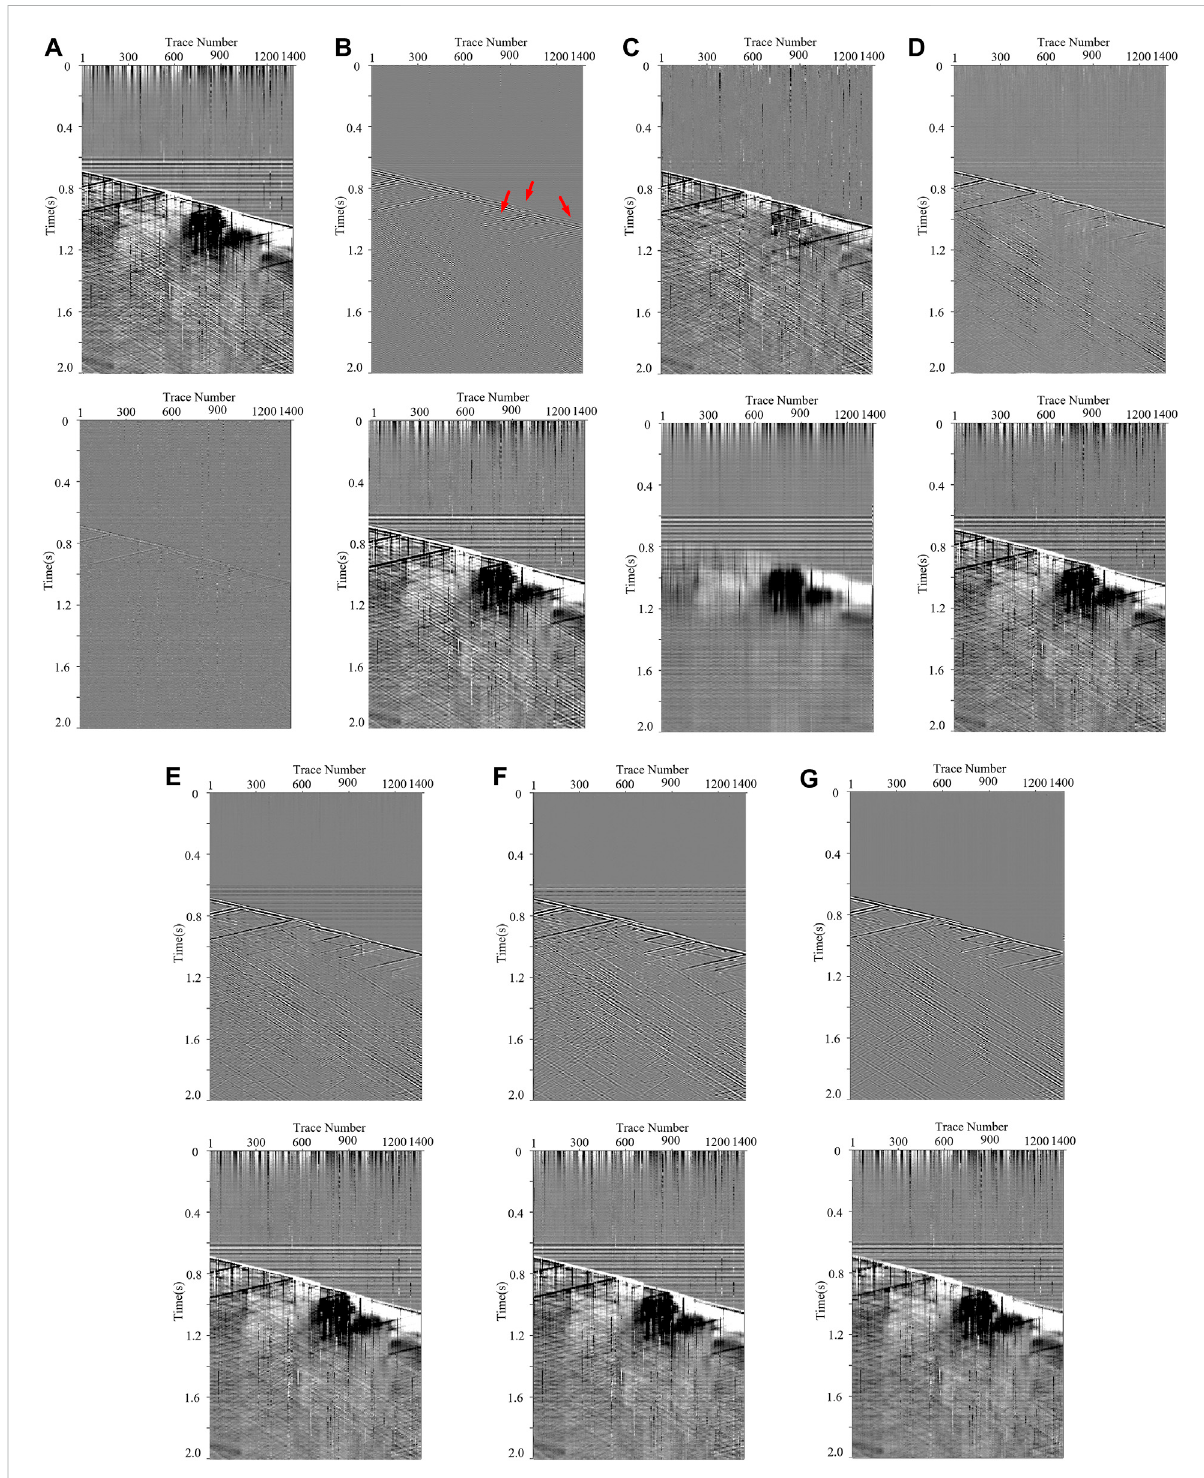
FIGURE 7 The processing results for the fi eld DAS data in Figure 6: (A – G) are the denoising results (top sub fi gures) and fi ltered noise (bottom sub fi gures) obtained by TFPF, BPF, RPCA, DnCNN, U-Net, RED-Net and MDD-Net.